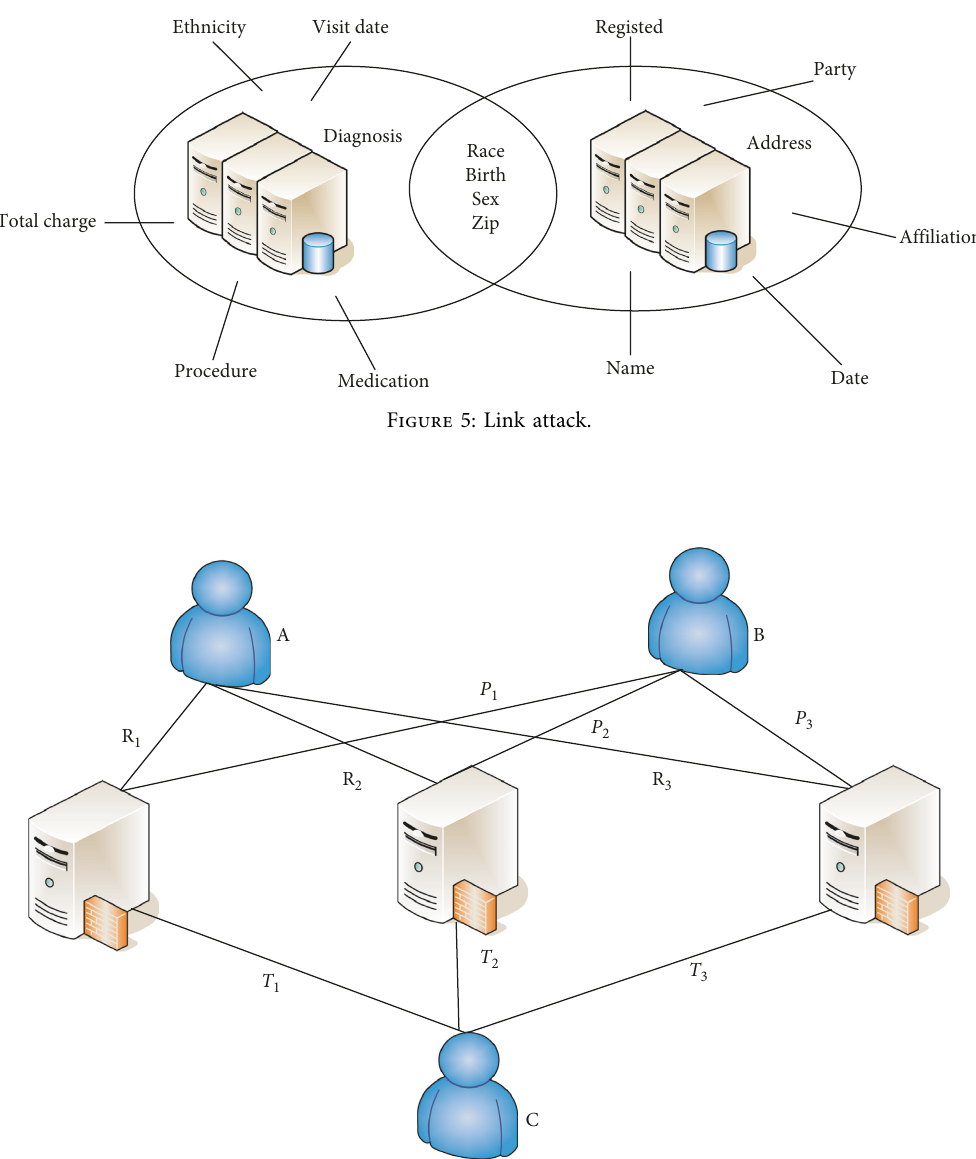
Figure 6: Additive secret sharing scheme.